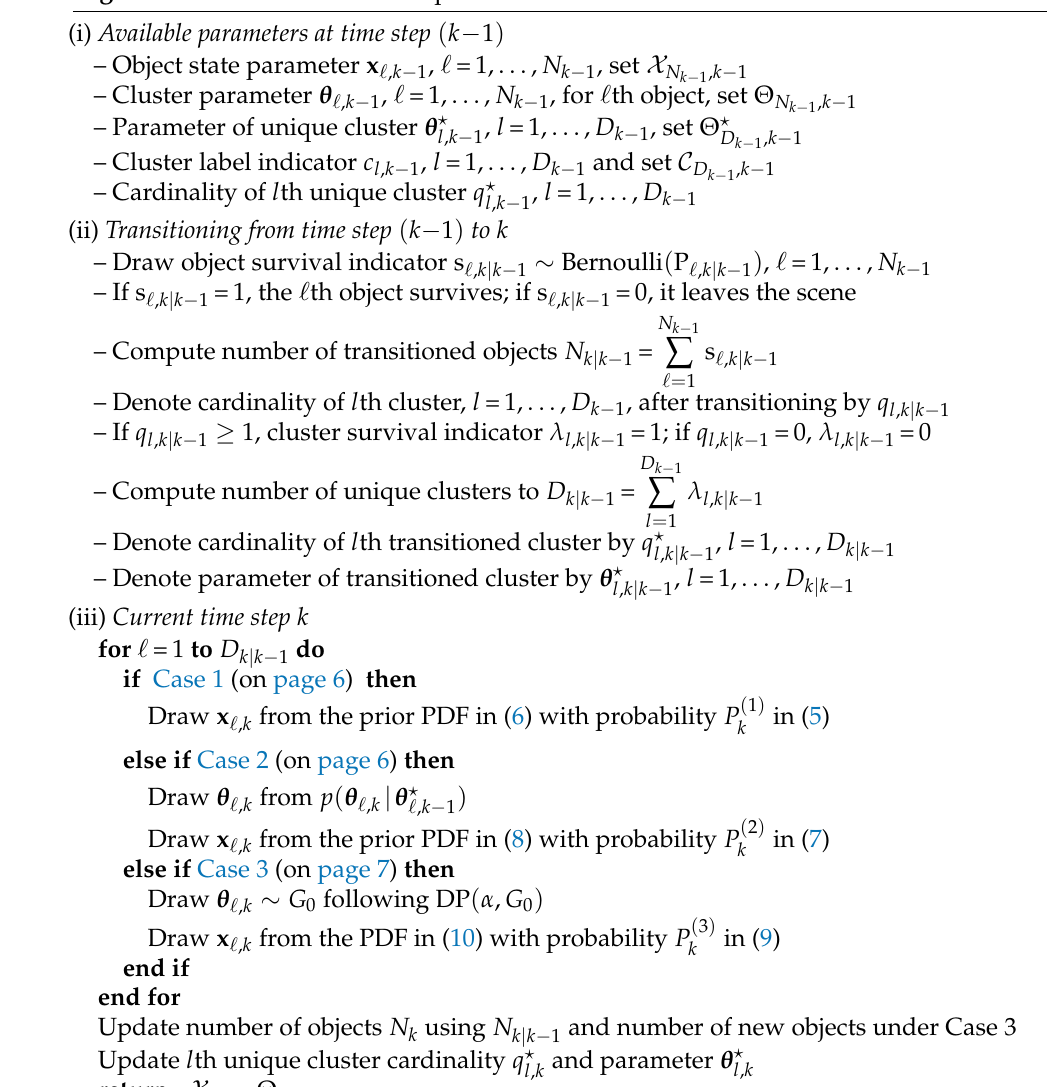
Algorithm 1 Construction of the prior distribution of